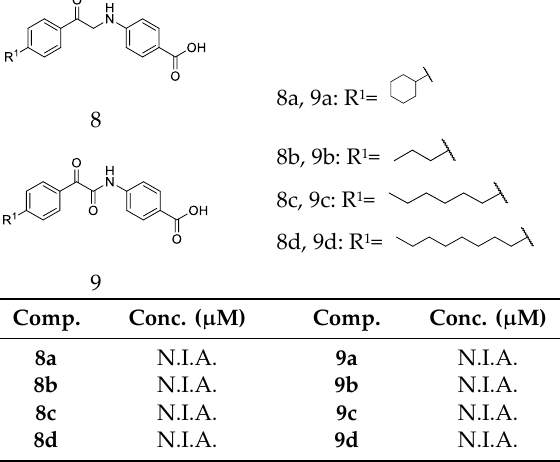
Table 3. The activities of 8a – 8d and 9a – 9d in combination with 2 μ g ·mL −1 colistin against the growth of BL21(DE3) expressing mcr-1 .